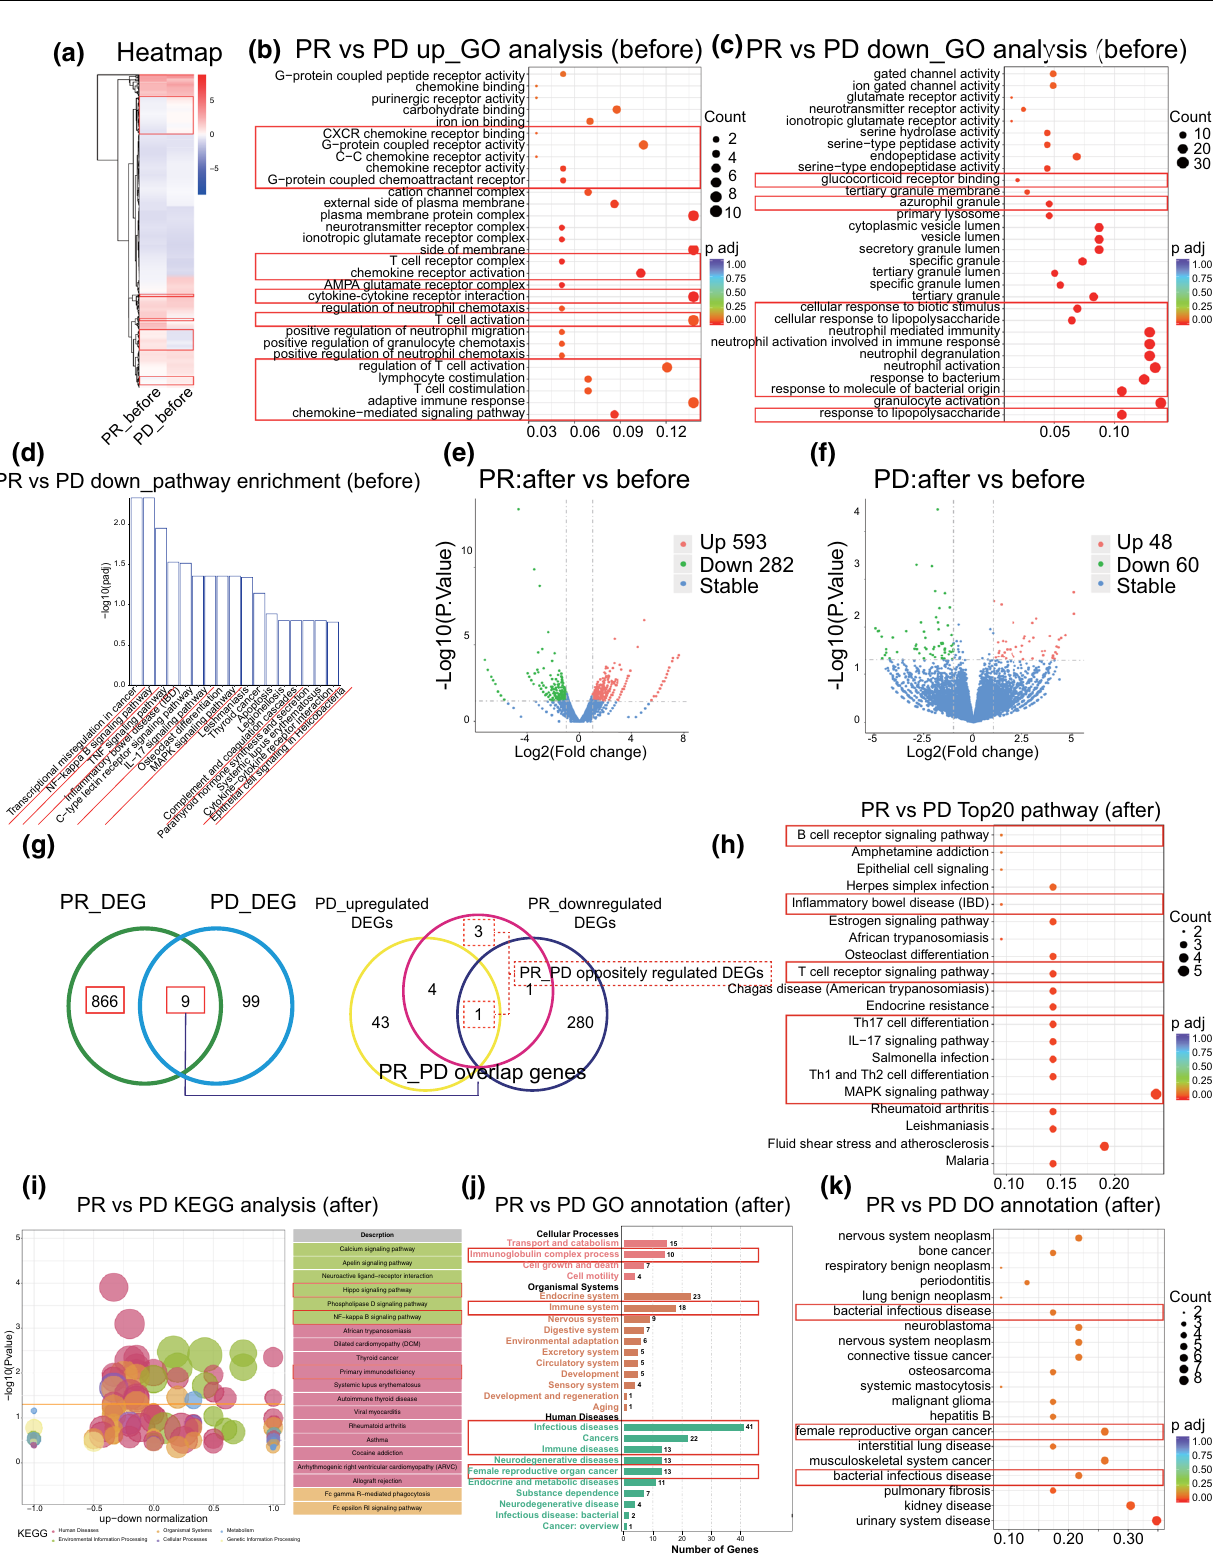
Fig. 3 Global transcriptome changes between PR and PD patients before and after treatment. A Heatmap showing DEGs between PR and PD patients prior to PD-1 monoclonal antibody treatment. B , C GO analysis of upregulated (b) and downregulated (c) genes between PR and PD patients before treatment. D Path- way analysis of downregulated genes between PR and PD patients before treatment. E–F Volcano plots of DEGs in PR (e) and PD patients (f) after treatment. P < 0.05, log2FC > 1. G Venn diagram showing 866 PR patient’s special DEGs and 4 oppositely regulated DEGs in PR and PD patients after treatment, which add up to a changing-fate gene set. H , I Top 20 pathways and KEGG analysis of changing-fate gene set. J , K GO and DO analysis of changing-fate gene